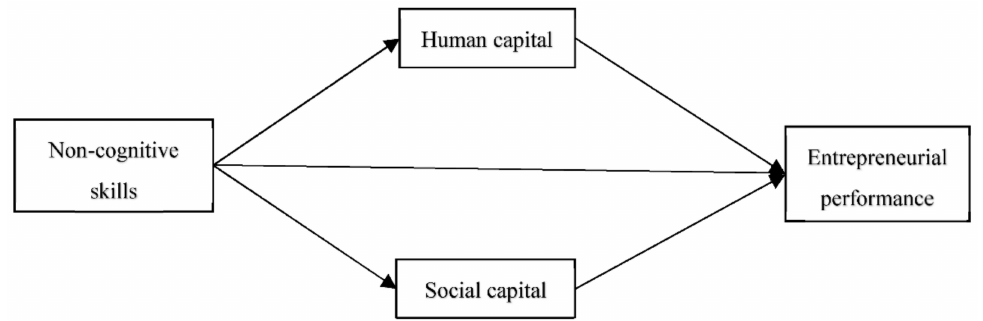
Figure 1. Theoretical framework of non-cognitive skills influencing farmers’ entrepreneurial